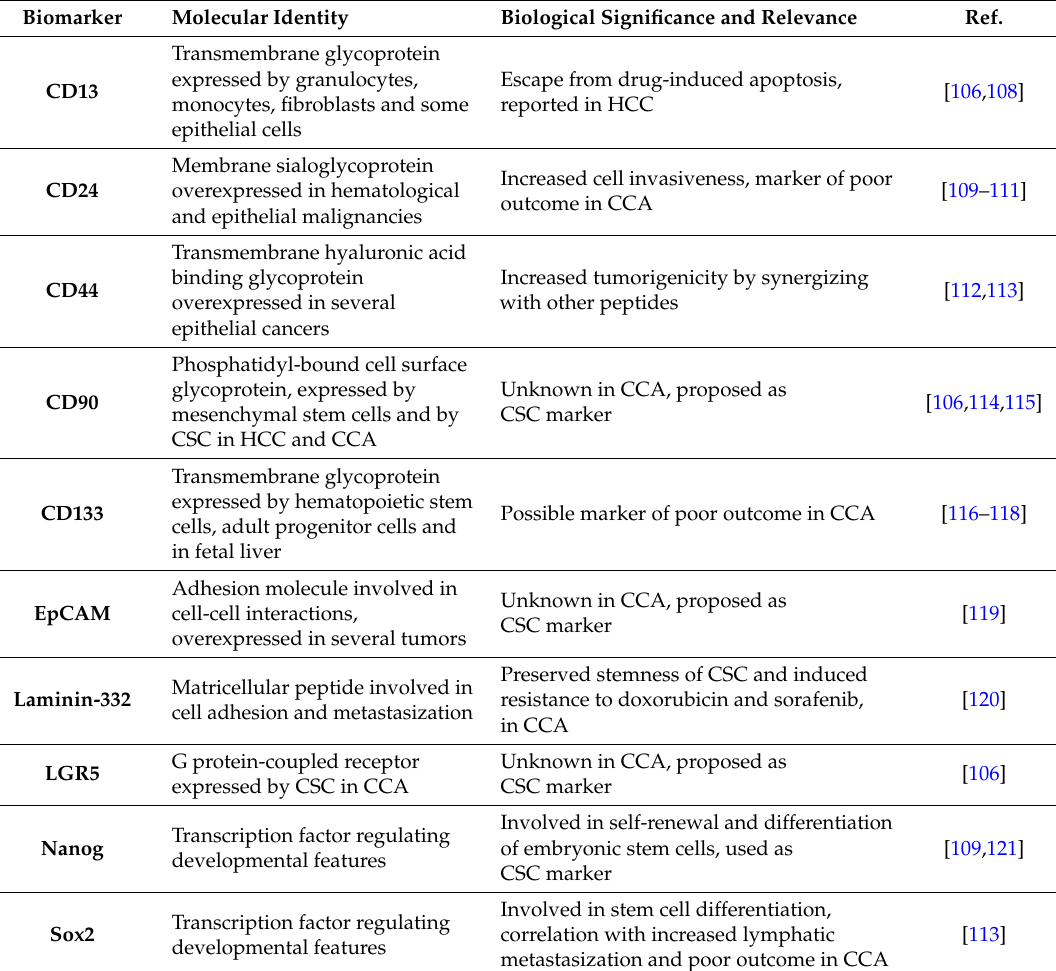
Table 1. Biomarkers of cancer stem cells (CSC) expressed in cholangiocarcinoma